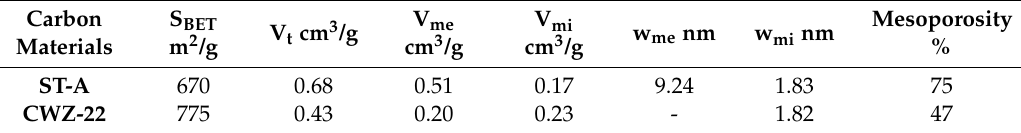
Table 2. Structural parameters of the studied carbon materials.